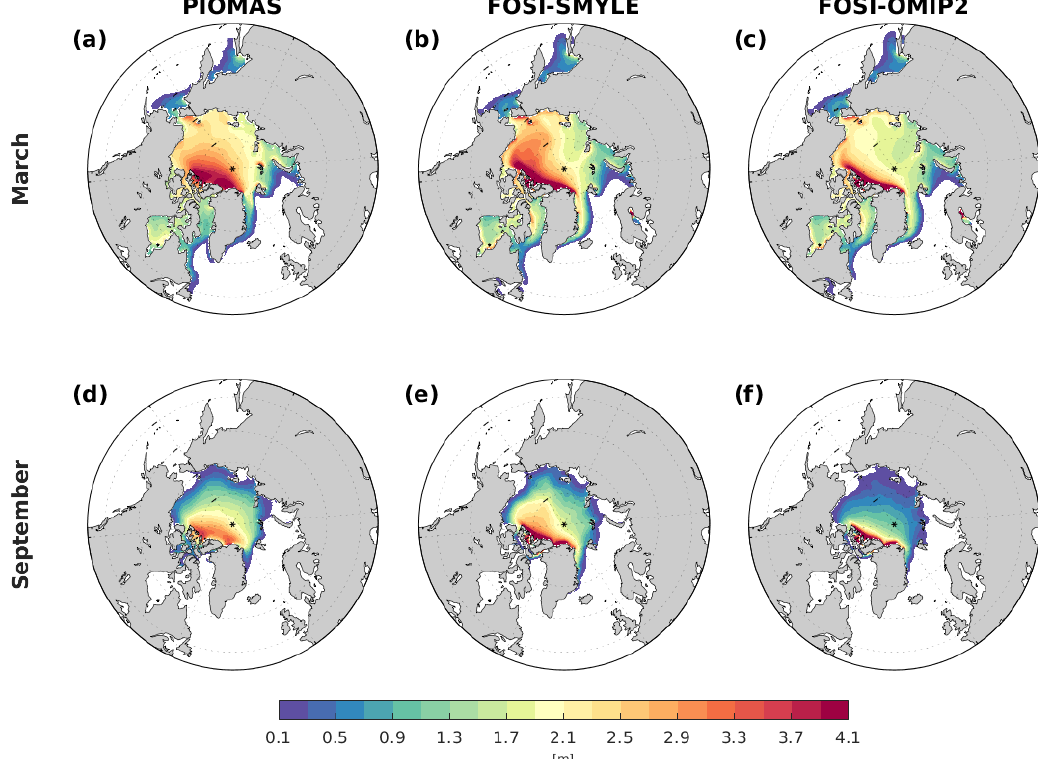
Figure A3. Climatological (1991–2010) sea ice thickness for March (a, b, c) and September (d, e, f) from (a, d) PIOMAS, (b, e) FOSI- SMYLE, and (c, f)